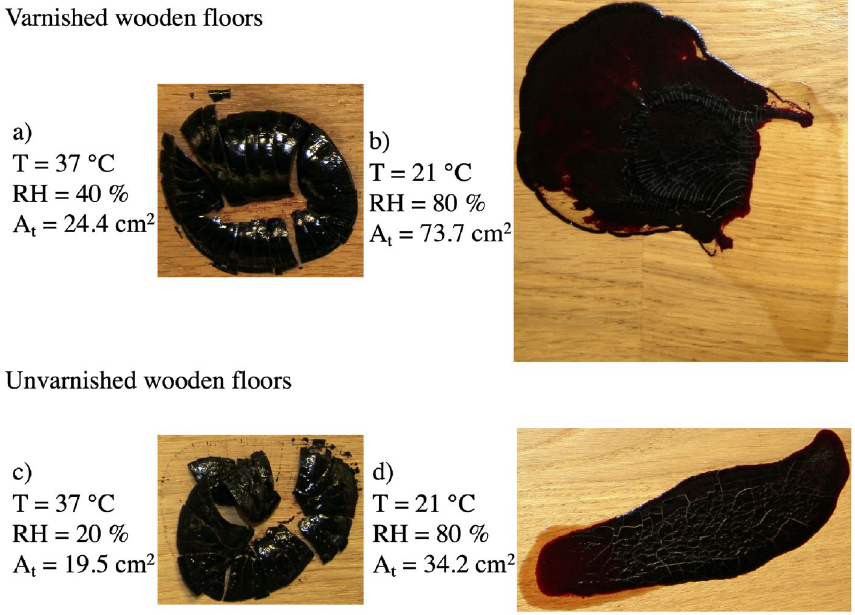
Figure 10. Final pattern of dried blood pools ( m i = 4.82 g ± 0.5% , hct = 42.8% ± 2.6% ) on varnished and unvarnished wooden floors as a function of relative humidity and temperature. A t is the total pool area.